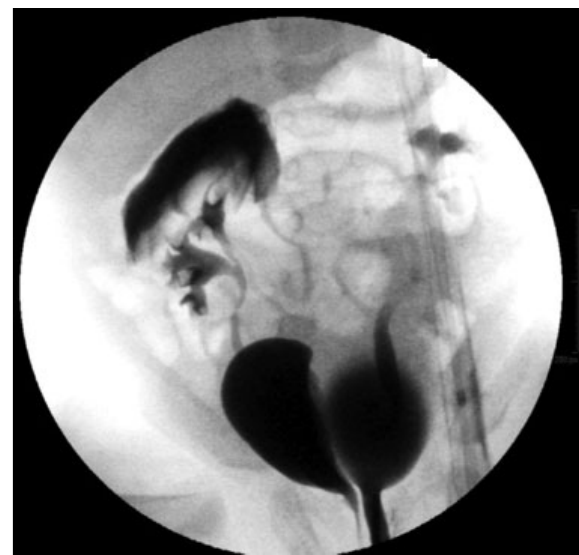
Fig. 3 Retrograde cystourethrogram showing two hemibladders and two completely separated